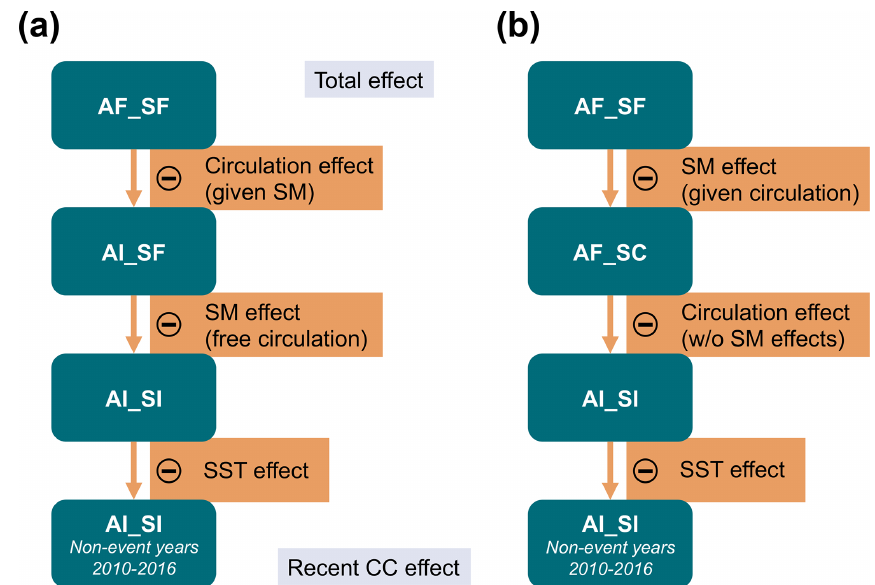
Figure 2. Schematic showing model experiments and effects isolated for extreme temperature events. For the experiments, the anomaly during the event (or during the same time of the year but for non-event years) is considered relative to the 1982–2008 climatology (turquoise rectangles). The magnitude of the anomaly in AF_SF is taken as the total effect, and the anomaly of AI_SI during non-event years is taken as the recent climate change (CC) effect (grey boxes). Further effects are disentangled by computing differences between the experiments along the orange arrows as indicated by the minus sign (orange rectangles). Two approaches (black letters a and b ) are followed, differing in how soil moisture (SM) contributions are separated from atmospheric circulation